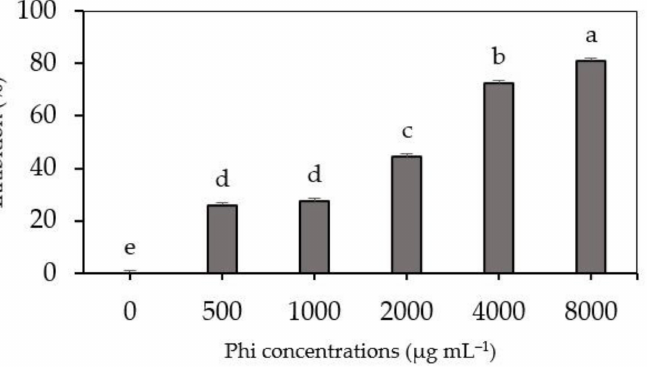
Figure 1. Mycelial growth inhibition (MGI) of Fusarium sp. in PDA culture medium, with the addition of Phi (0, 500, 1000, 2000, 4000 and 8000 µ g mL − 1 Phi). Means ± SD with different letters are statistically different (Fisher’s test; α = 0.05). Phi–phosphite. A fung-istatic effect on MGI (%) was observed when Phi was added to the medium. A fungicidal effect from 500 µ g mL − 1 was observed on the conidiogenesis of Fusarium sp., as it decreased by 99.7% compared to the control (Table 2). Table 2. Conidiogenesis of Fusarium sp. (spores mL − 1 ) with Phi addition to the PDA culture medium.